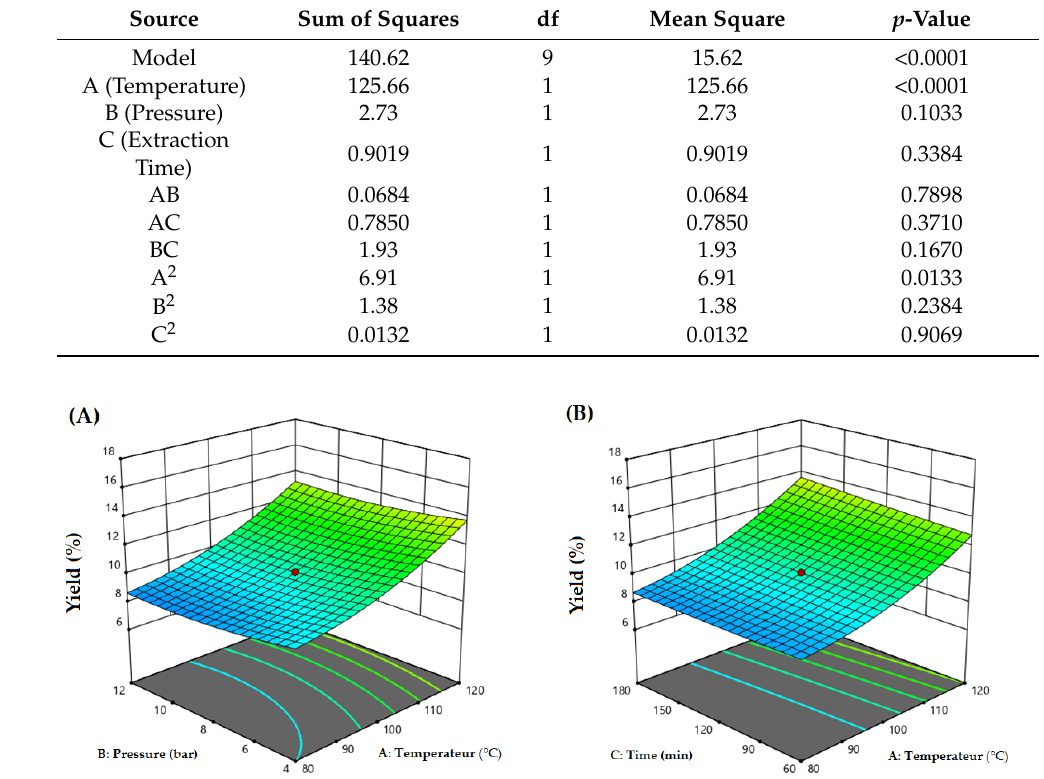
Figure 1. Response surface plot demonstrating the effect of ( A ) temperature and pressure and ( B ) temperature and extraction time on the % yield of polysaccharides. Table 3. The analysis of variance (ANOVA) table for the response surface quadratic model of the % yield of polysaccharides.